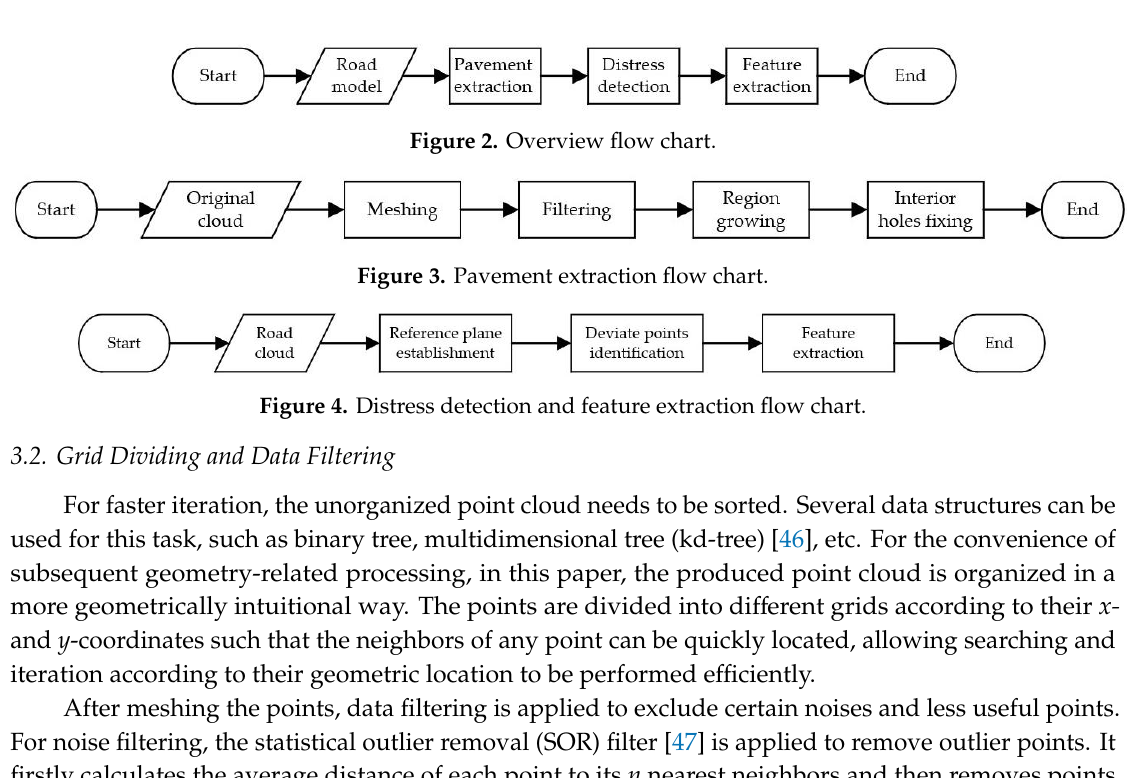
Figure 3. Pavement extraction flow chart.